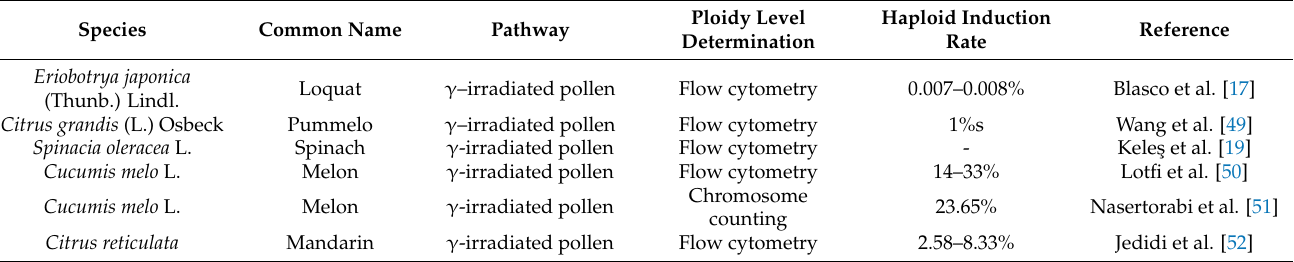
Table 3. Examples of successful haploid induction methods by induced parthenogenesis by irradiated pollen in recalcitrant